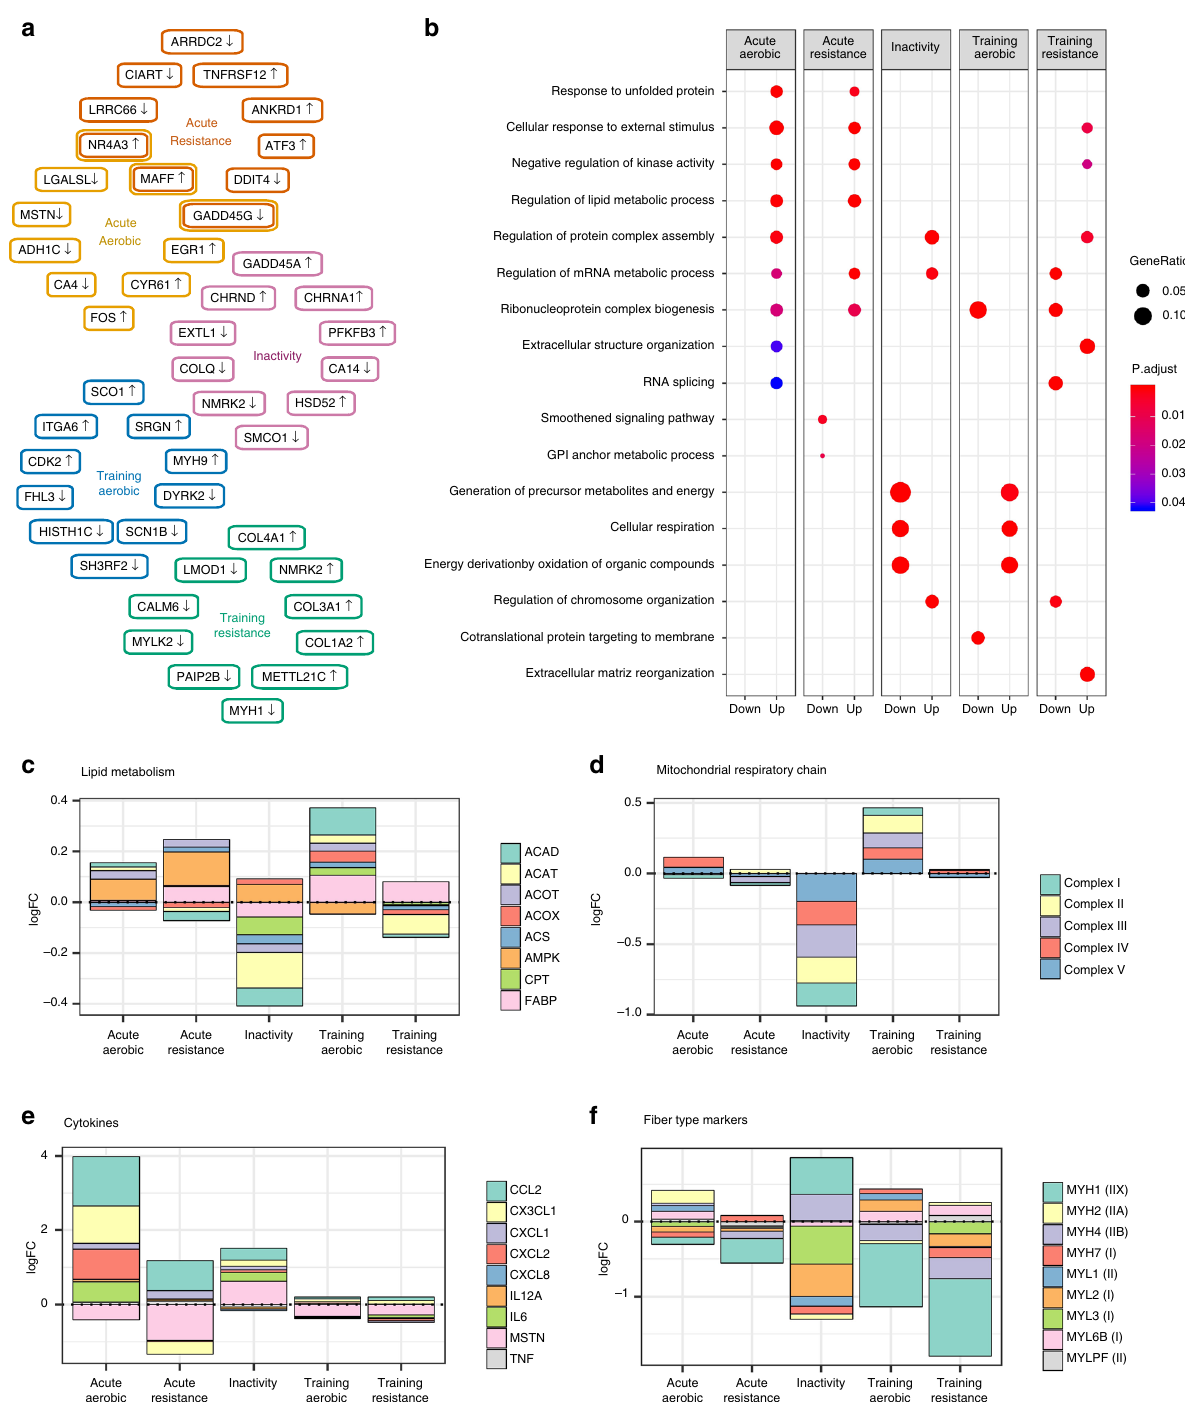
Fig. 3 Genes and pathways altered by exercise and inactivity. The top 5 up- and downregulated genes in each protocol and their overlap was calculated ( a ) and gene ontology analysis was calculated based on genes with FDR < 0.01 ( b ). Genes corresponding to the proteins of interest were collected from the KEGG database and fold-changes were added to present the overall modi fi cation of enzymes involved in pathways. The behavior of lipid metabolism signaling ( c ), mitochondrial respiration ( d ), in fl ammation ( e ), and muscle fi ber composition ( f ) are